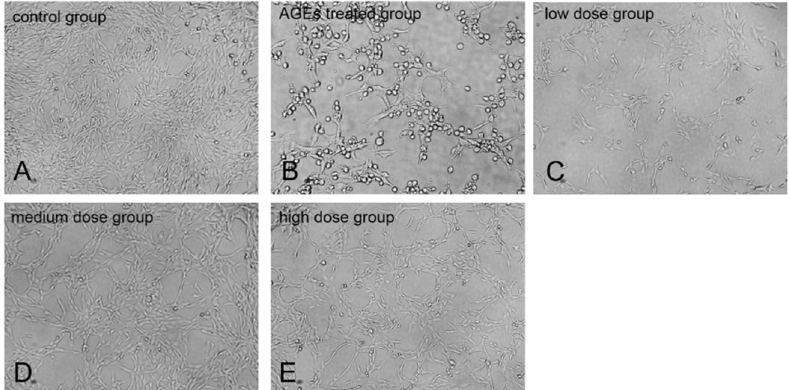
Figure 2. KM treatment protects against AGE-induced GMC injury. Microphotographs of the recovery effect of KM on AGE-induced growth of ( A ) control group GMCs, ( B ) cells treated with AGEs (160 µ g/mL) for 24 h, and ( C – E ) cells pre-treated with 10, 20, or 35 µ M KM and then stimulated with AGEs (160 µ g/mL) for 24 h. The photographs were taken directly from culture plates with an inverted fluorescence microscope (magnification 100 × ).